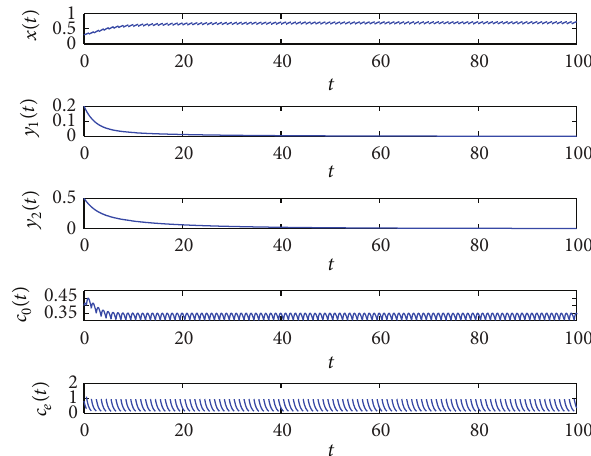
Figure 1: Time series of system (2) with parameters 𝛽 = 0.9 , 𝐾 = 0.8 , 𝑞 = 0.8 , 𝑑 = 0.4 , 𝜏 = 0.5 , 𝜆 = 0.8 , 𝛾 = 0.3 , 𝑏 = 0.1 , 𝑘 = = 0.2 , 𝑓 = 0.1 , 𝛿 = 0.1 , 𝛼 = 0.2 , ℎ = 2 , 𝑔 = 0.2 , 𝑚 = 0.4 , 0.5 , 𝑓 2 1 and 𝑇 = 1 .